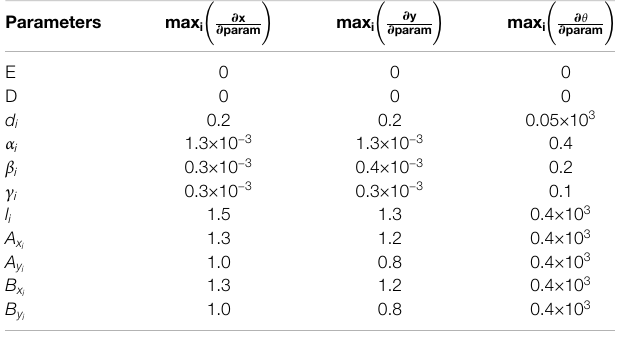
TABLE 2 | In fl uences of the different models ’ parameters (expressed in SI base unit) computed as the maximal fi nite difference for the different con fi gurations and